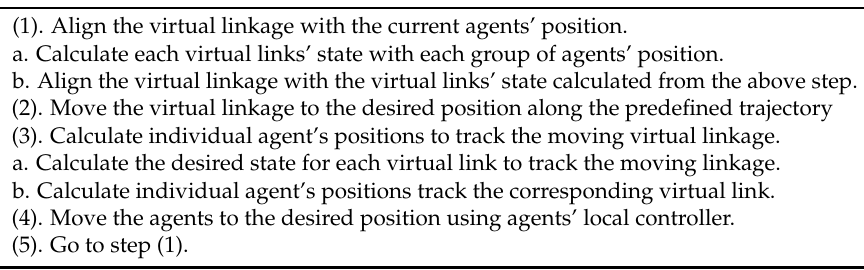
Table 1. Moving-in-formation algorithm using virtual